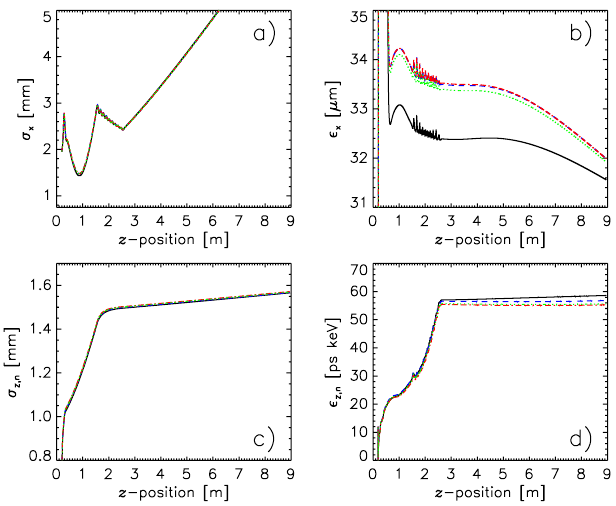
FIG. 13. (Color) Distribution 2 : The same as in Fig. 12, only for Distribution 2 .